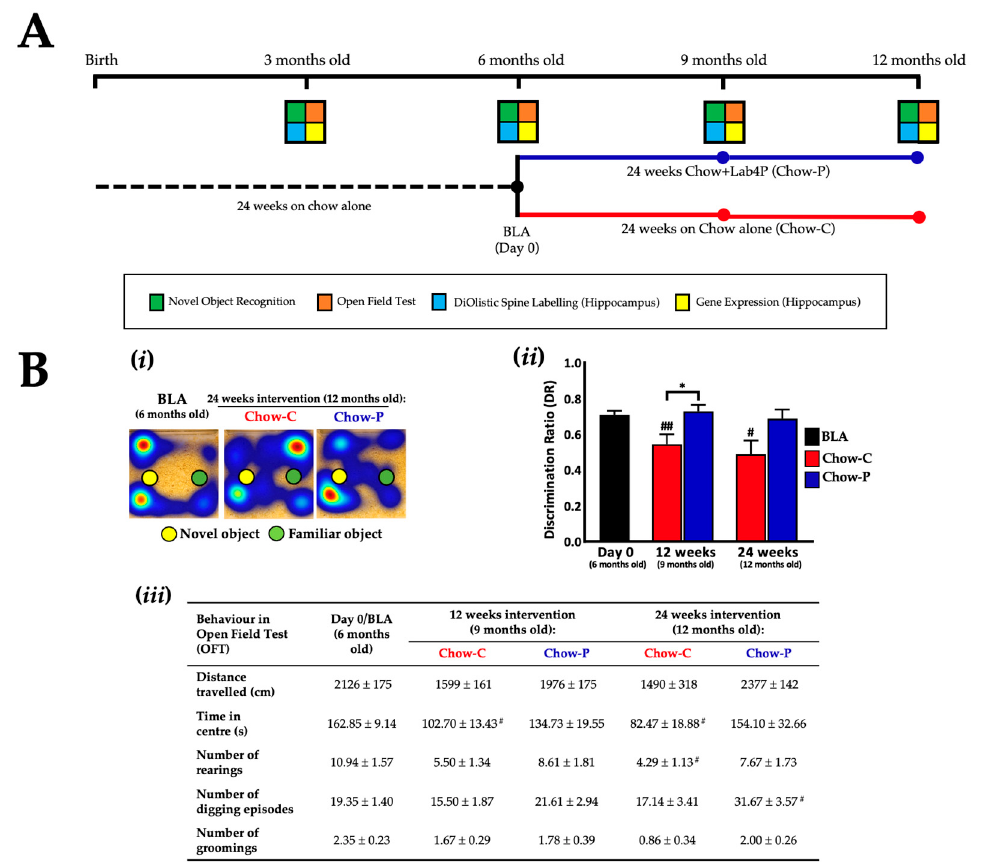
Figure 1. The impact of 24 weeks supplementation with Lab4P on cognition in3xTg-AD mice (Study A). ( A ) 3xTg-AD study design and test/sample collection schedule. Six-month-old male 3xTg-AD mice received a chow diet with or without Lab4P for 24 weeks. Circles indicate analysis time points. BLA, Baseline for study A; BLB, Baseline for study B. ( B-i ) Representative heat maps of mouse movements and ( B-ii ) changes from baseline (BLA) in discrimination ratio (DR) as determined during NOR testing or ( B-iii ) changes from baseline in behaviour during open field testing (OFT) of 3xTg-AD mice receiving chow alone (Chow-C) or chow plus Lab4P (Chow-P) for 24 weeks. Data are ex-